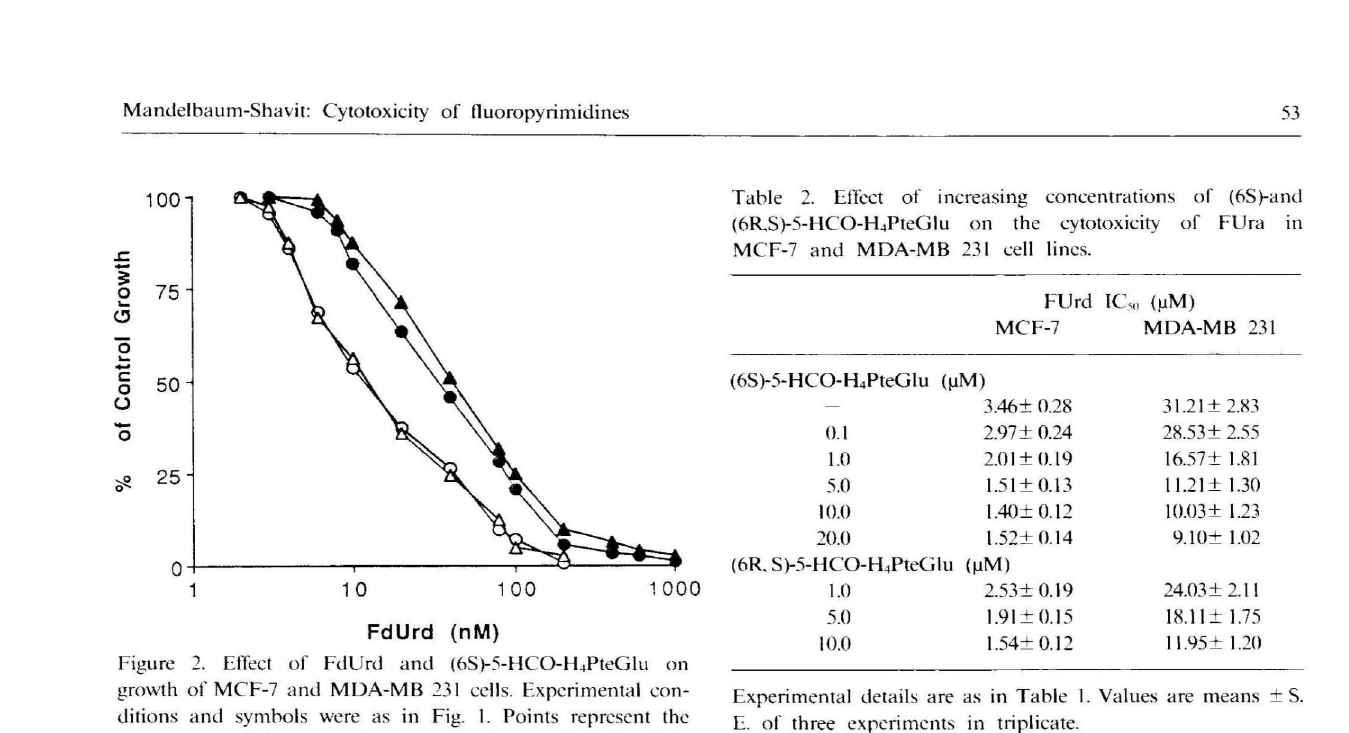
Figure 2. Effect of FdUrd and (6S)-S-HCO-H4PteGlu on growth of MCF-7 and MDA-MB 231 cells. Experimental con ditions and symbols were as in Fig. 1. Points represent the mean value of three experiments in triplicate with S.E. within the symbols.